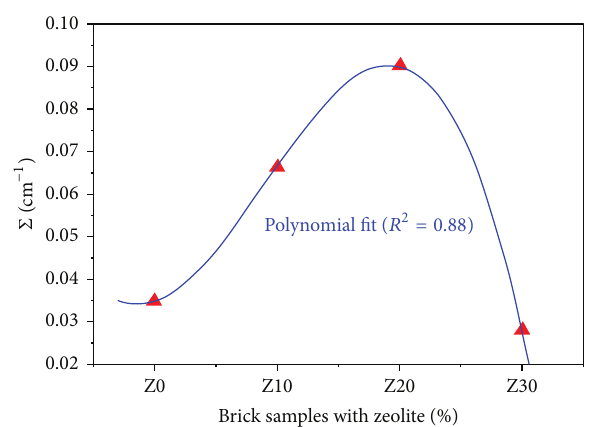
Figure 3: 4.5 MeV neutron macroscopic cross sections of bricks as a function of natural zeolite percentage.